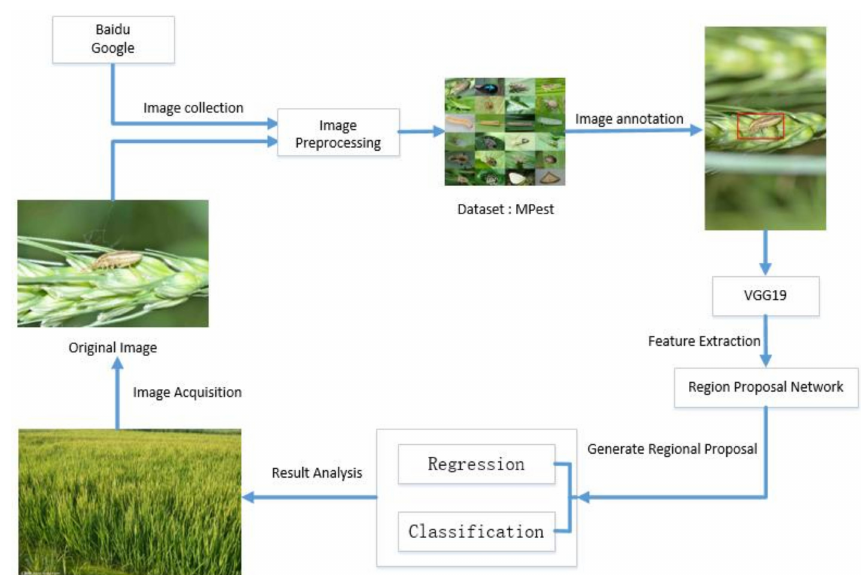
Figure 4. Flowchart of insect recognition and classification. Abundant images were obtained by taking photos in crop fields and collecting images by Baidu and Google online, in which insect images are original and the quality of insect images are uneven. Then, image preprocessing and data augmentation were applied to form our own dataset “MPest”. The model, which was trained on the dataset “MPest”, can effectively help to recognize insects and